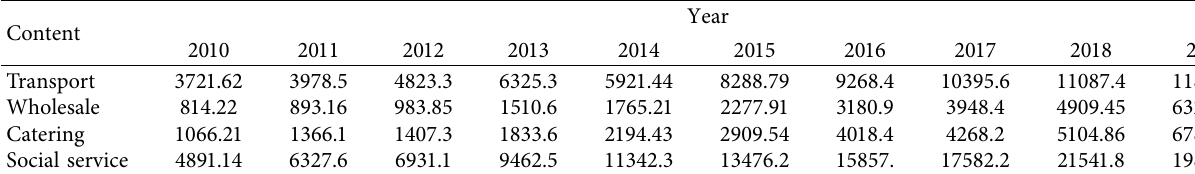
Table 3: Carbon emissions by